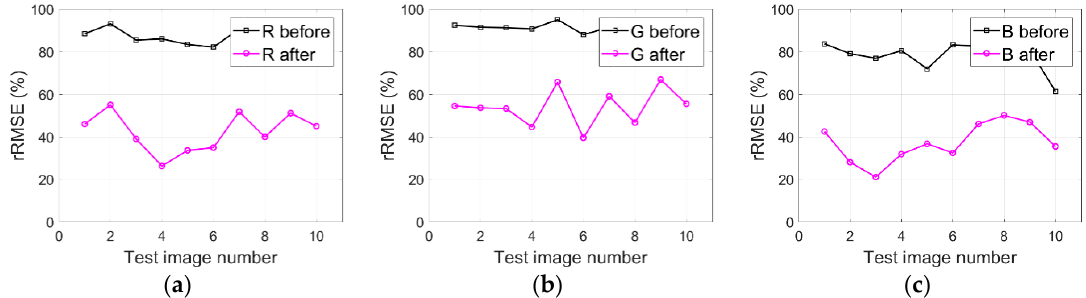
Figure 18. IRB method generalization analysis for WV2-WDC images in terms of R, G, and Figure18.